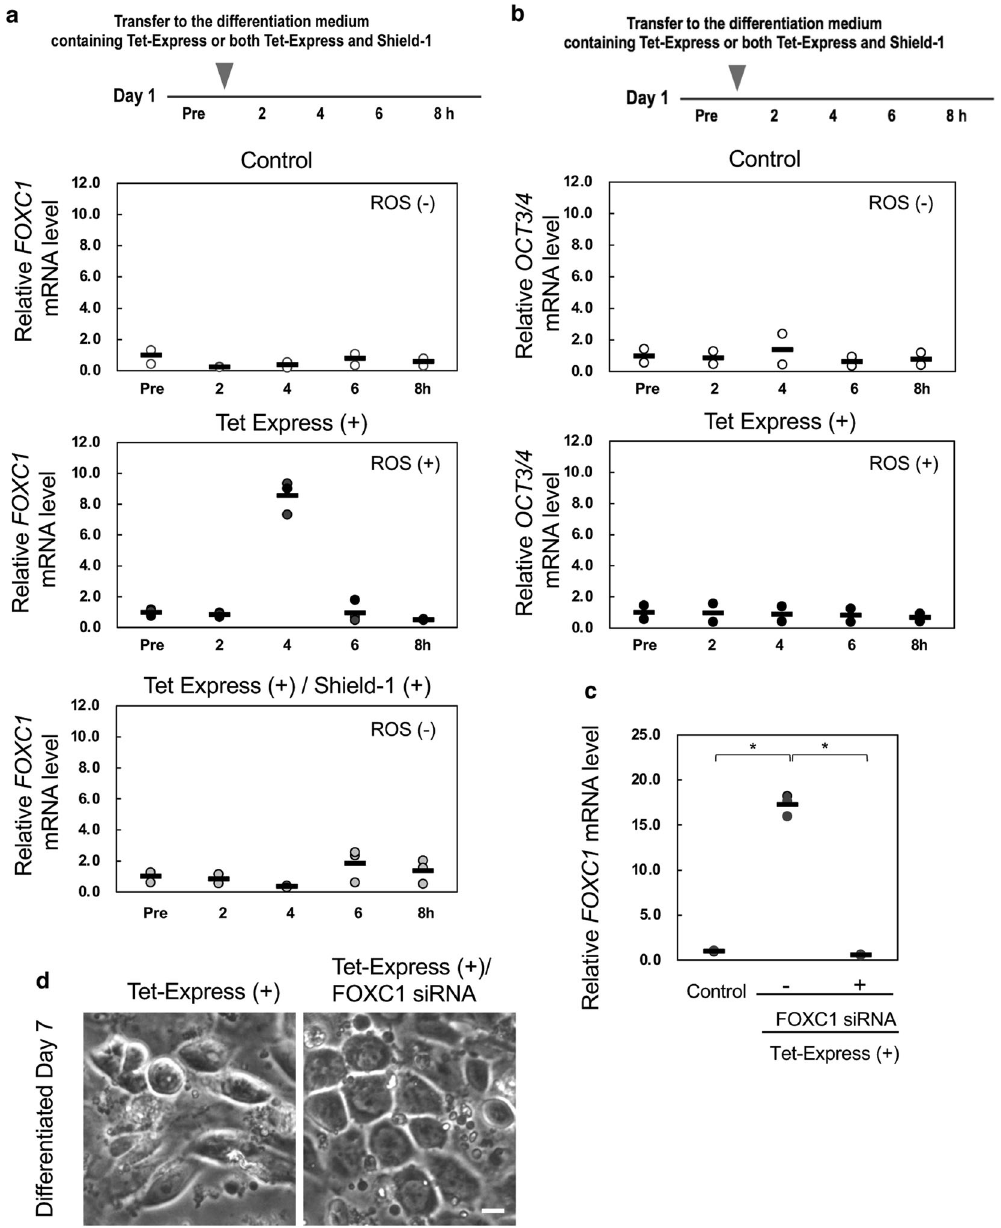
Fig. 5 The expression of FOXC1 was transiently increased on early differentiation in a human iPS cell line showing increased endogenous ROS production. a Expression level of FOXC1 mRNA by real-time RT-PCR analysis in ChiPSC12-CAT cells. Cells were cultured for 2, 4, 6, and 8 h after replacement with Day 1 differentiation medium containing only Tet-Express (Catalase [ − ]) or both Tet-Express and Shield-1 (Catalase [ + ]). Control: cells cultured without Tet-Express or Shield-1. Bars represent the means. N = 3. b Expression level of Oct3/4 mRNA by real-time RT-PCR analysis in ChiPSC12-CAT cells. N = 2. c Con fi rmation of FOXC1 knockdown in the early stage of differentiation on Day 1 by real-time RT-PCR analysis. Control: cells cultured without Tet-Express. Cells were treated FOXC1 siRNA on Day 0 and then cultured with differentiation medium containing Tet-Express. Bars represent the means. N = 3. Wilcoxon exact test (two-sided), * p = 0.0286. d FOXC1 knockdown in the early stage of differentiation rescued differentiation impairment on Day 7 in ChiPSC12-CAT cells producing ROS. Tet-Express: Cells were cultured with differentiation medium containing Tet-Express for 7 days. Tet-Express/ FOXC1 siRNA: cells were treated FOXC1 siRNA on Day 0 and then cultured with differentiation medium containing Tet-Express for 7 days. Scale bar, 20 μ m. Results from one of three independent experiment are presented.